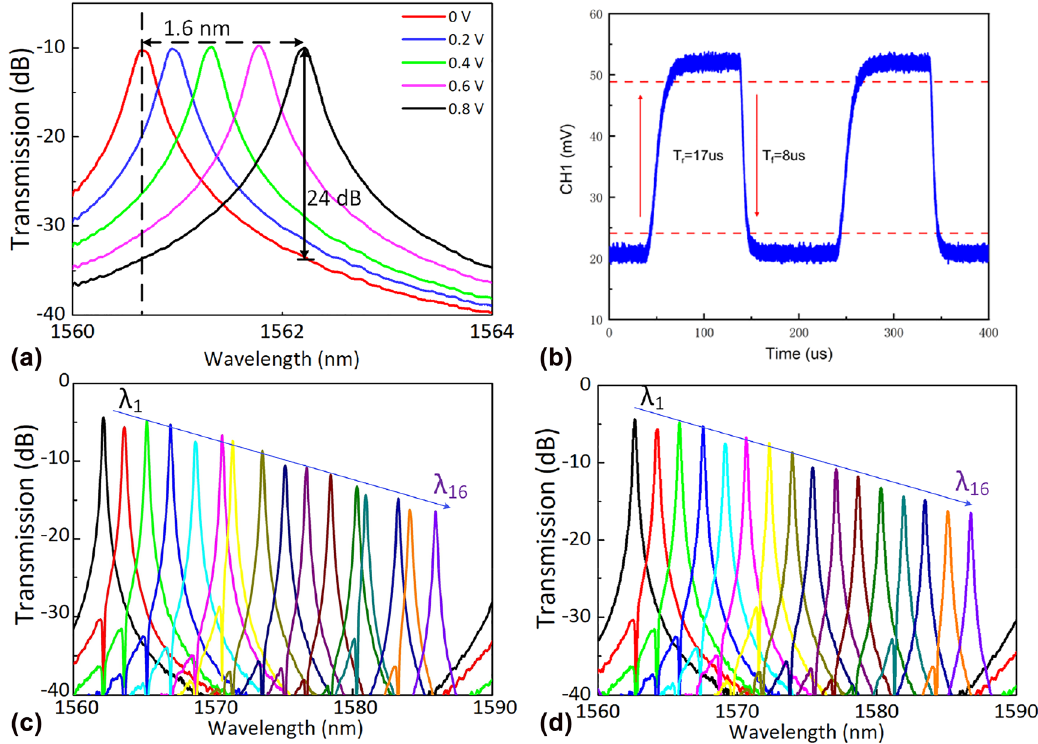
Figure 12: Measured transmissions (a) and switching responses (b) of the MRR-based wavelength-selective switch operating with different heating voltages. The measured drop spectra of the 16 MRR-based wavelength-selective switch without (c) and with (d) heater